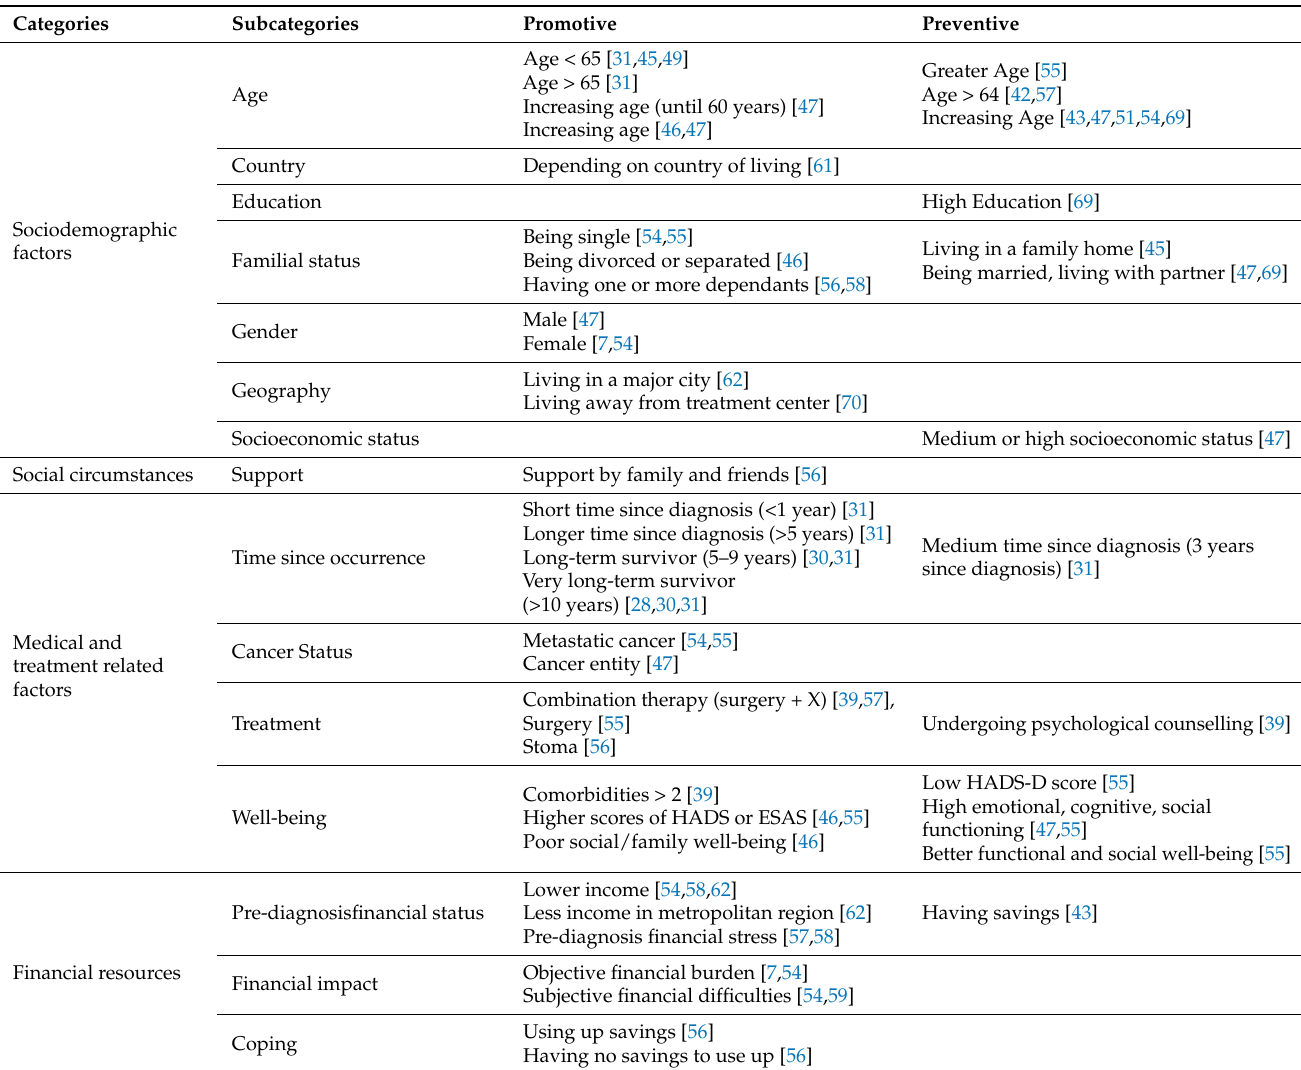
Table 3. Effects of quantified risk